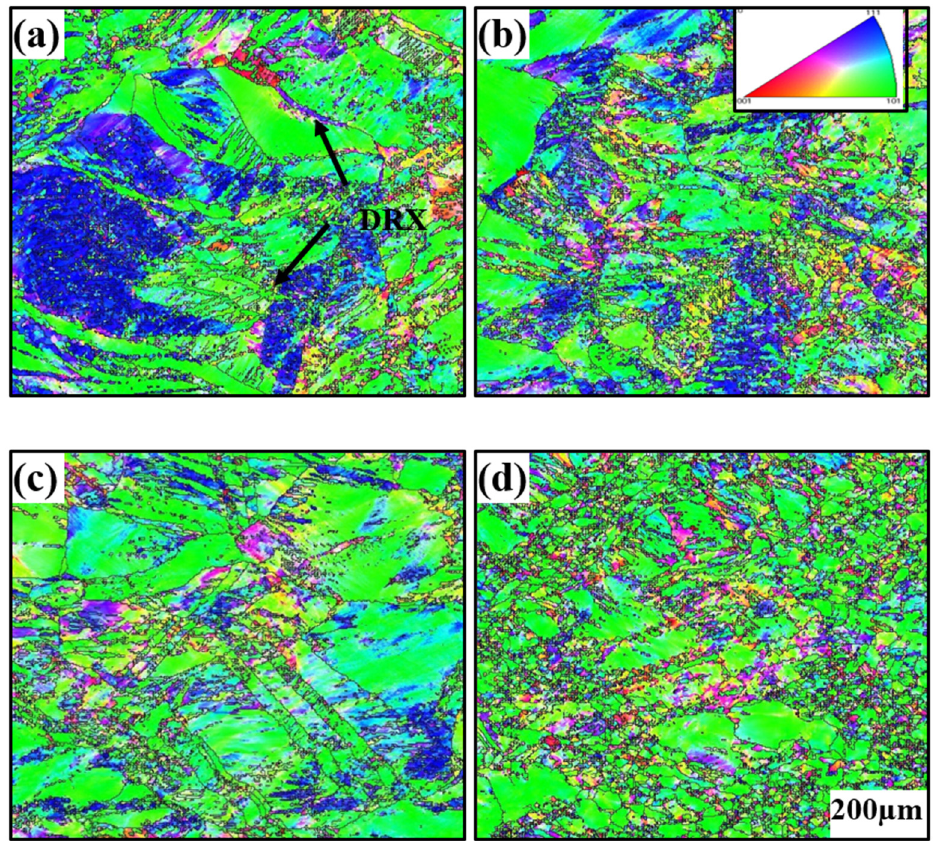
Figure 4. Maps showing grain orientation distribution at different temperatures: ( a ) 200 °C, ( b ) 300 °C, ( c ) 400 °C, and ( d ) 500 °C.